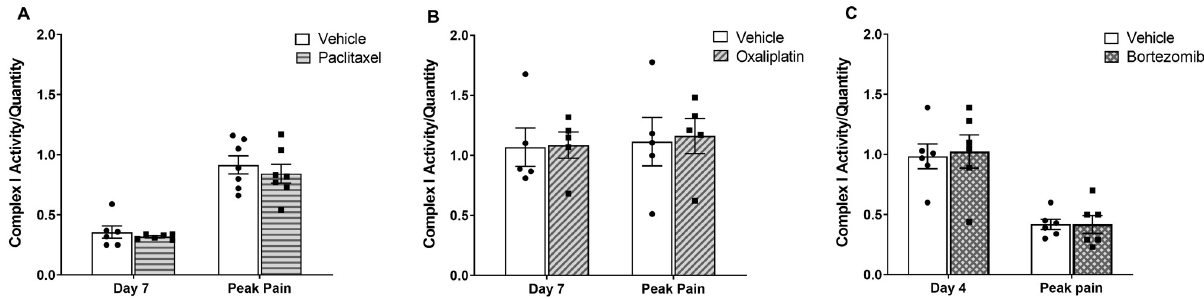
Fig 4. Mitochondrial Complex I activity in whole blood following chemotherapy administration. Complex I activity is normalized to Complex I quantity. (A) Complex I activity in animals administered with four injections of 2 mg/kg paclitaxel or an equal volume of vehicle solution. Day 7: n = 6 per group; peak pain: n = 7 per group. (B) Complex I activity in animals administered with four injections of 2 mg/kg oxaliplatin or an equal volume of vehicle solution. Day 7 and peak pain: n = 5 per group. (C) Complex I activity in animals administered with four injections of 0.2 mg/kg bortezomib or an equal volume of vehicle solution. Day 4 and peak pain: n = 6 per group. Data are expressed as mean ± SEM. Unpaired two-tailed t